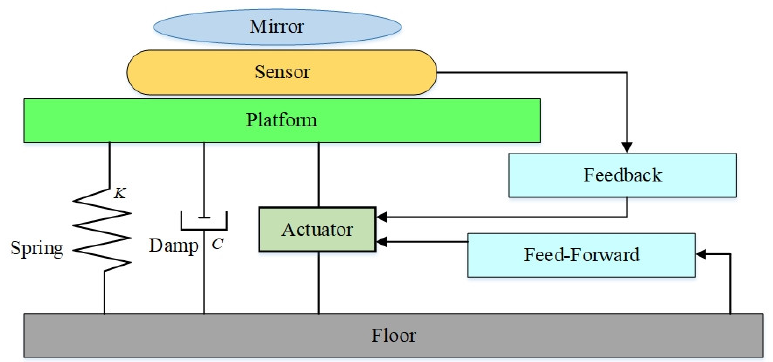
Figure 4. Composition of an active vibration isolation system.